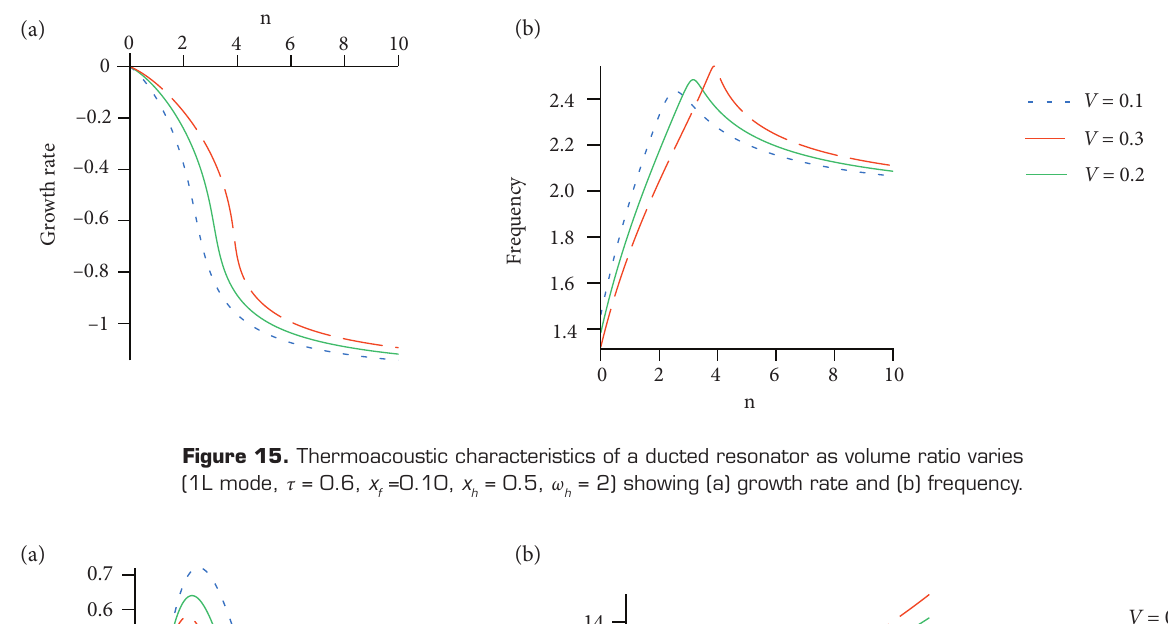
showing (a) growth rate and (b) frequency.